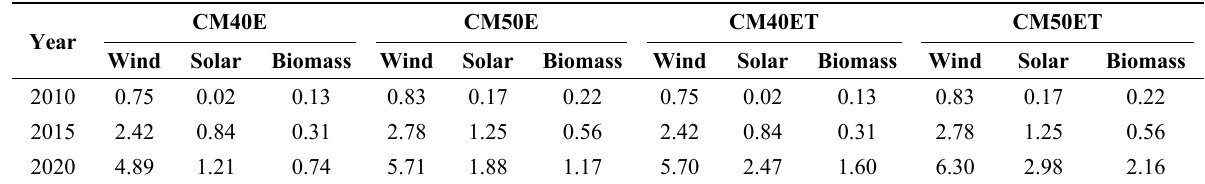
Table A2. The estimated feed-in subsidies for the renewable during the study period (Billion USD).